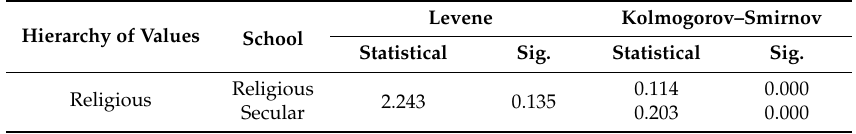
Table A1. Results of the parametric assumptions for the school variable (religious values